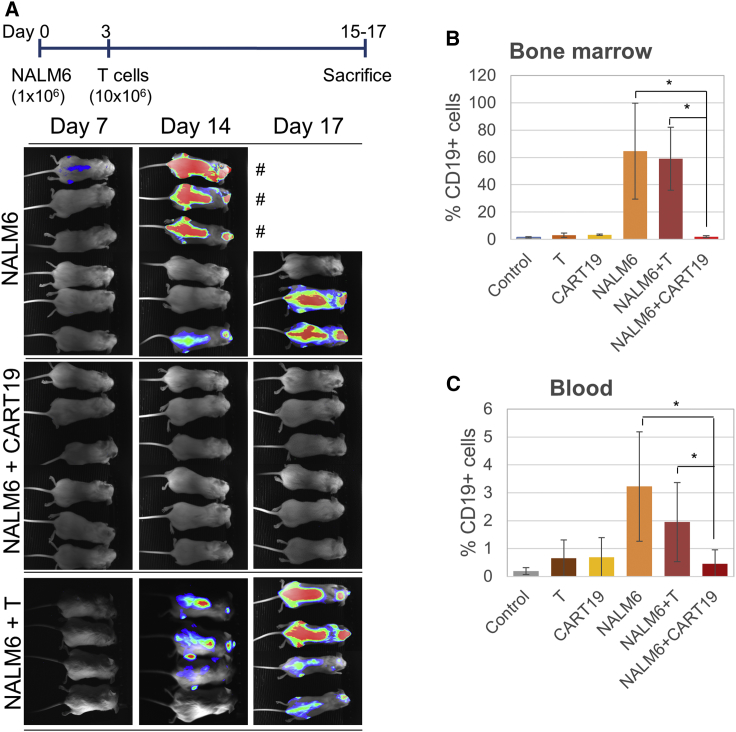
ARI-0001 Anti-tumor Activity In Vivo(A) Upper panel shows a timeline of experimental design. Lower panels show bioluminescence images showing disease progression at different days. Animals indicated by a pound sign were sacrificed at day 16 due to advanced disease progression. The rest of the animals were sacrificed at day 17. (B) Detection of tumor (CD19+) cells in the bone marrow of mice shown in (A) (mean ± SD). (C) Detection of tumor (CD19+) cells in blood.